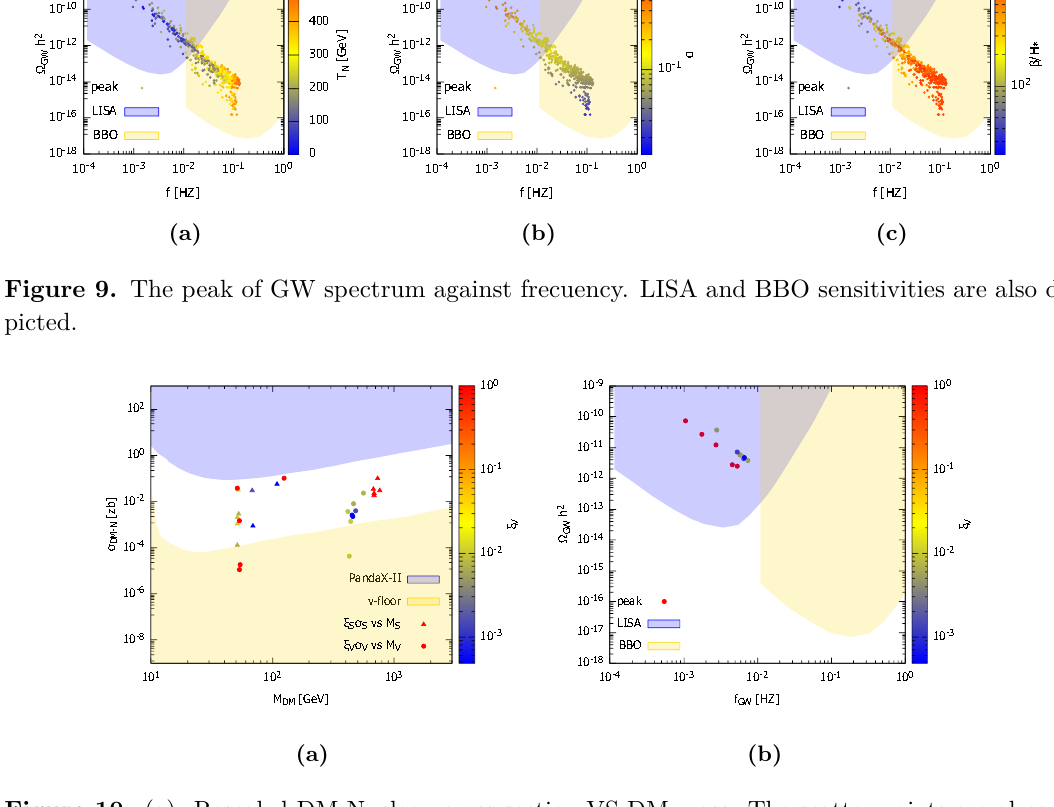
Figure 10. (a): Rescaled DM-Nucleon cross section VS DM mass. The scatter points are already consistent with DM relic density (3.6) and direct detection (3.15) constraints. (b): GW peak VS frequncy for the same points of the parameter